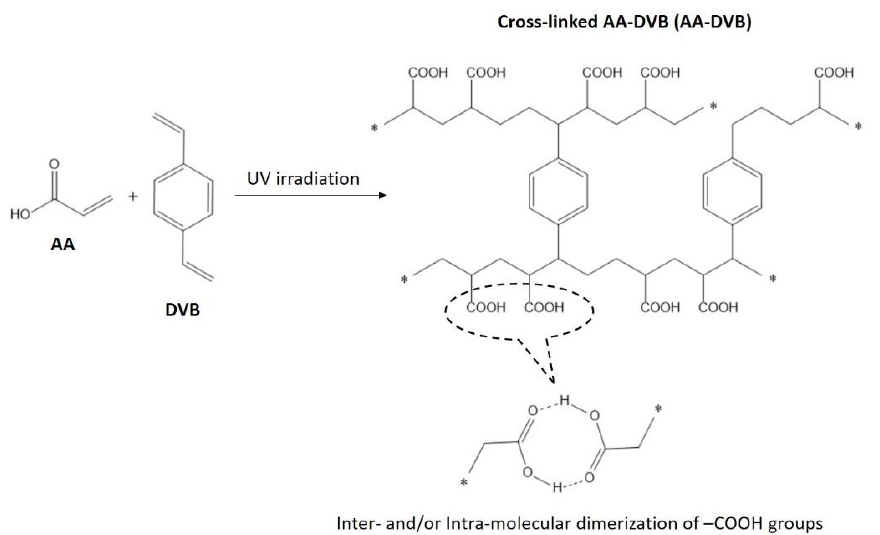
Figure 1. Chemical structure of AA-DVB polymeric network used as the C layer.